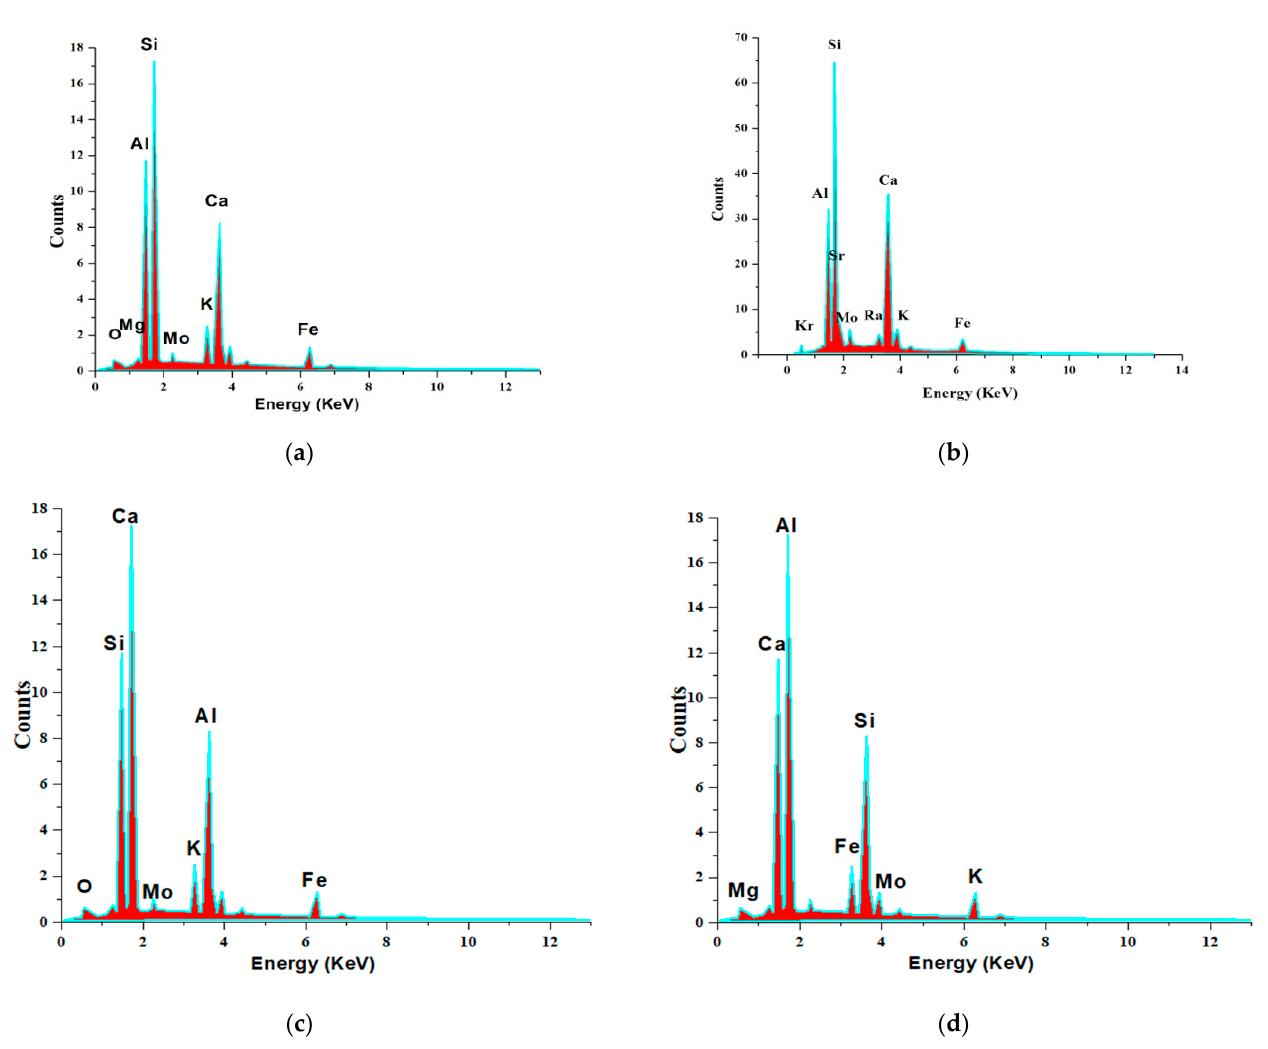
Figure 3. EDX micrographs of: ( a ) specimens containing 5 wt% of stabilisation; ( b ) specimens containing 10 wt% of stabilisation; ( c ) specimens containing 15 wt% of stabilisation; ( d ) specimens containing 20 wt% of stabilisation.